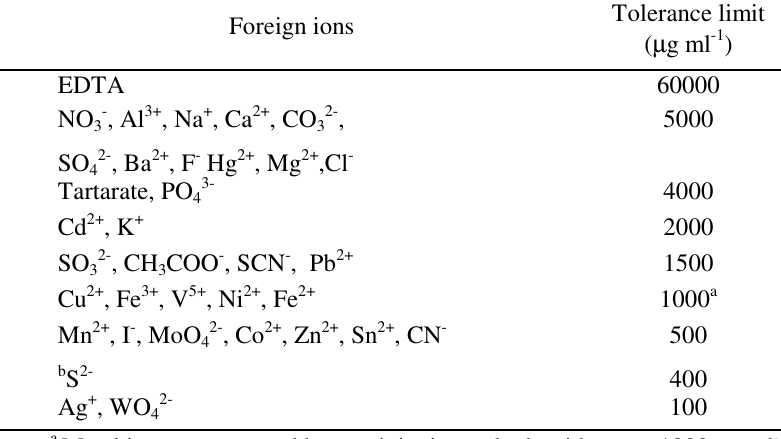
Table 1. Effect of Diverse Species on the Determination of Nitrite (0.4- m G Ml -1 ).